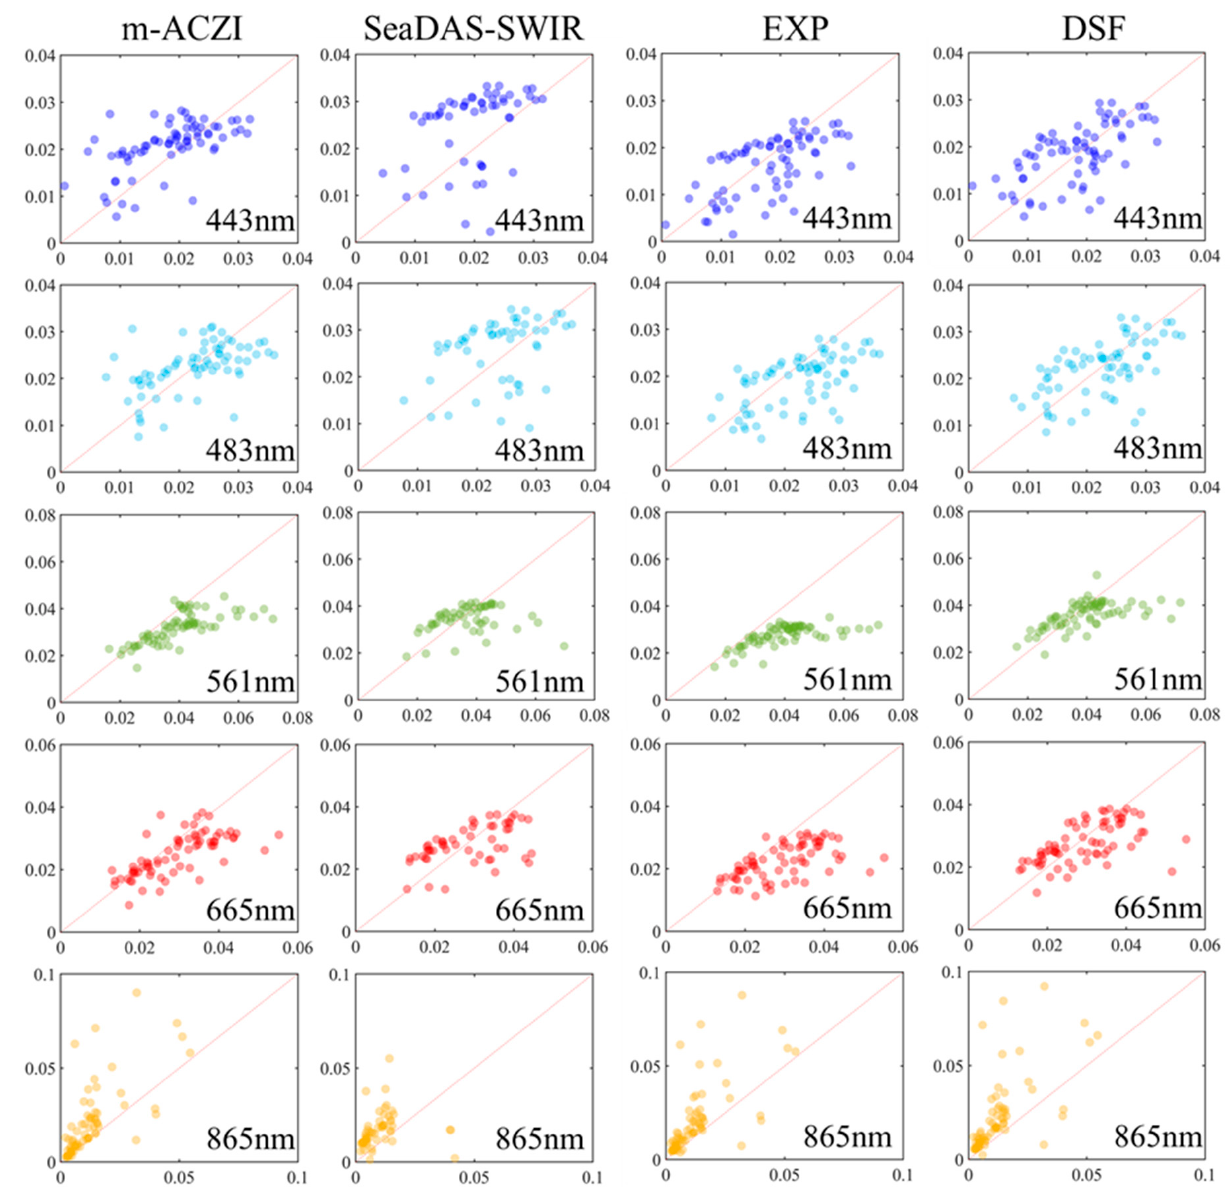
Figure 10. Sca tt erplots of AC-driven R rs versus in situ R rs . Figure 10. Scatterplots of AC-driven R rs versus in situ R rs Table 2. Statistics of the accuracy measures for the m-ACZI, SeaDAS, DSF, and EXP algorithms us- ing in situ R rs measurements. The BLUE number represents the minimal statistical value.